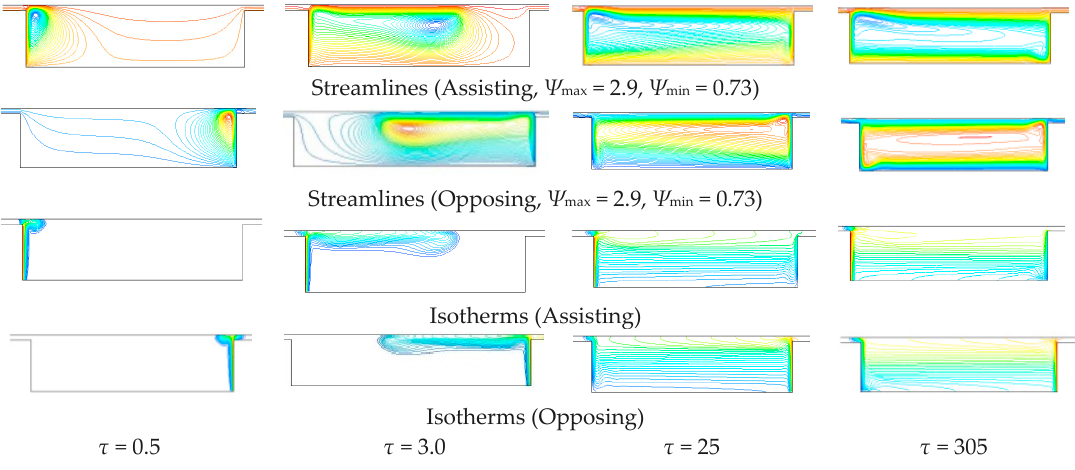
Figure 8. Streamlines and isotherms for Re = 1000, aspect ratio (AR) = 4.0 and Ri = 6.54.